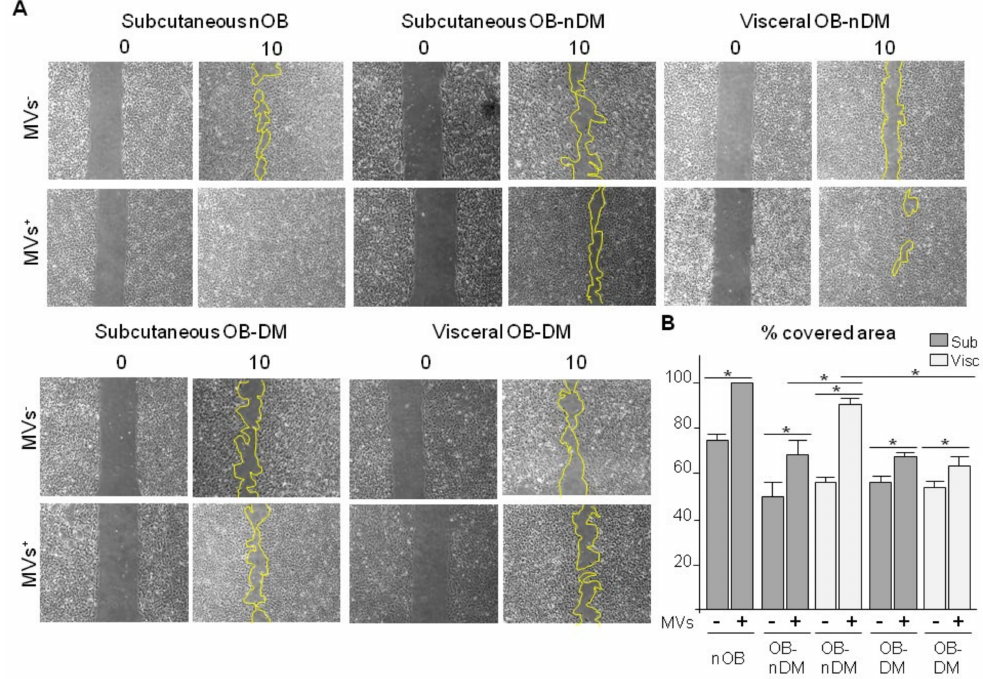
Figure 7. E ff ect of ASC-MVs in endothelial cell migration. Human microvascular endothelial (HMEC-1) cells treated with ASC conditioned medium, MVs depleted or MVs rich medium. ( A ) Images show the wound repair at 10 h; ( B ) Cell coverage of the wounded area at 10 h. Results are expressed as % of covered wounded area ± SEM. * p < 0.05.